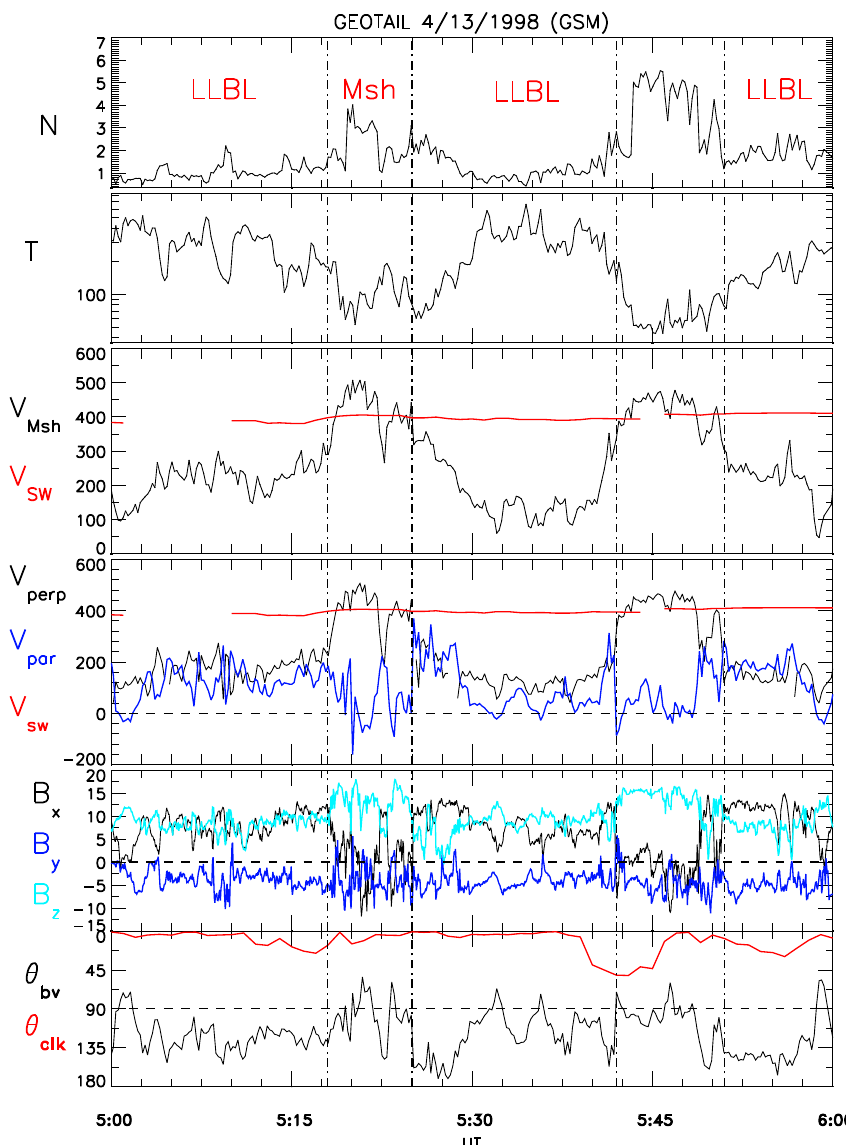
Fig. 2. Event on 13 April 1998. Two crossings into the magnetosheath are shown between pairs of vertical guidelines where the maximum sheath speed exceeds that of the solar